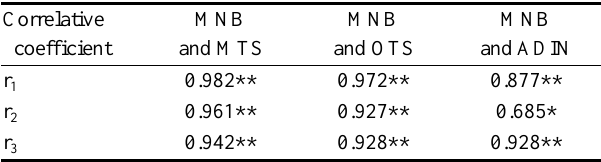
Table 6. Correlative coefficients of the feed DRUP values measured by mobile nylon bag method and other methods